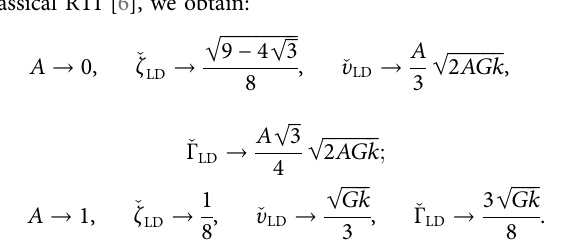
The fastest bubble of the family of solutions we refer to as the “ Atwood bubble ” in order to emphasise its dependence on the Atwood number. The Atwood bubble parameters are complicated functions of the Atwood number A and the acceleration strength G .